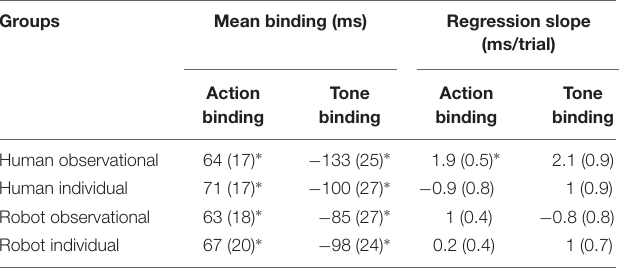
TABLE 1 | The mean (and standard error across participants) for binding, and robust regression slope showing the relation between binding and trial